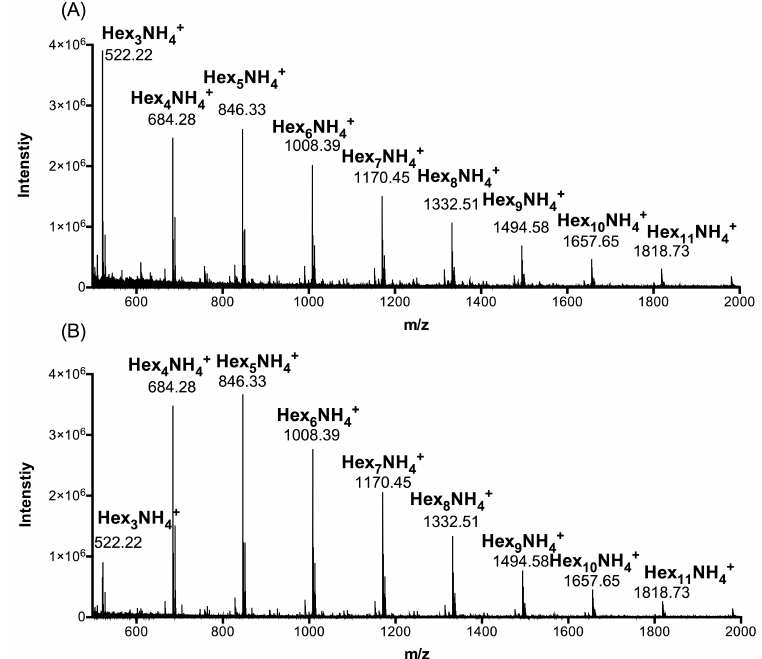
Figure 1. UPLC-MS analysis of Antrodia cinnamomea (AC) polysaccharides at 90 °C (ACHO) or 25 °C (ACCO). ( A ) Polymerization degree identification of ACCO; ( B ) Polymerization degree identification of ACHO. Hex represents hexose.